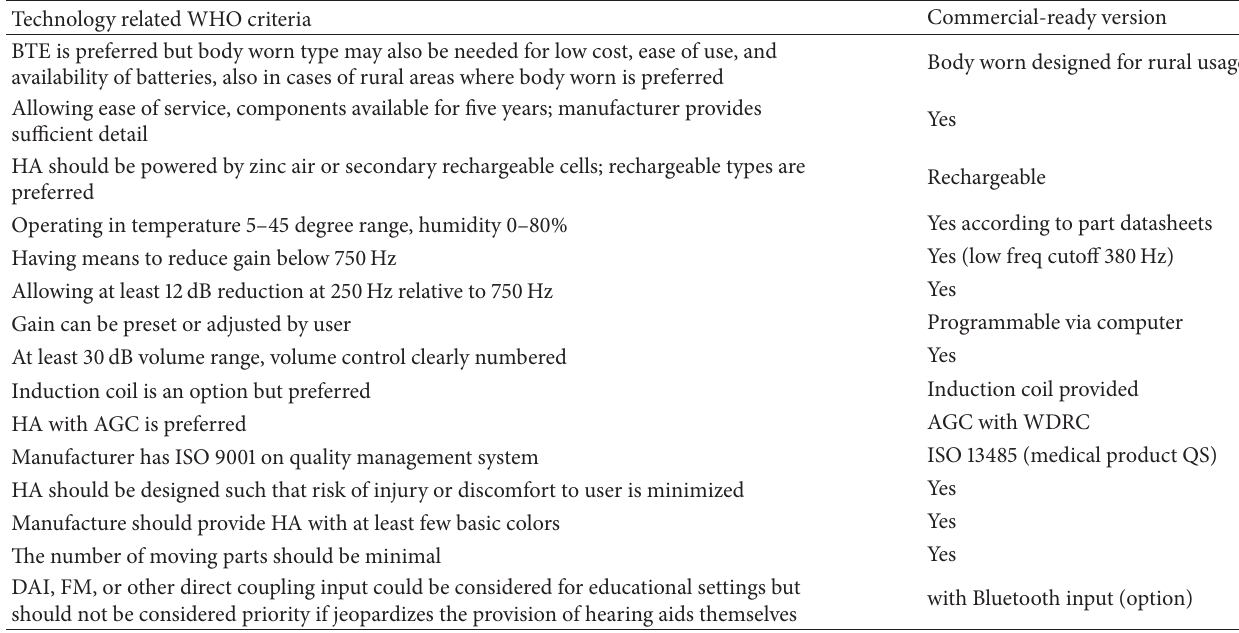
Table 6: Specifications of the commercial-ready version.